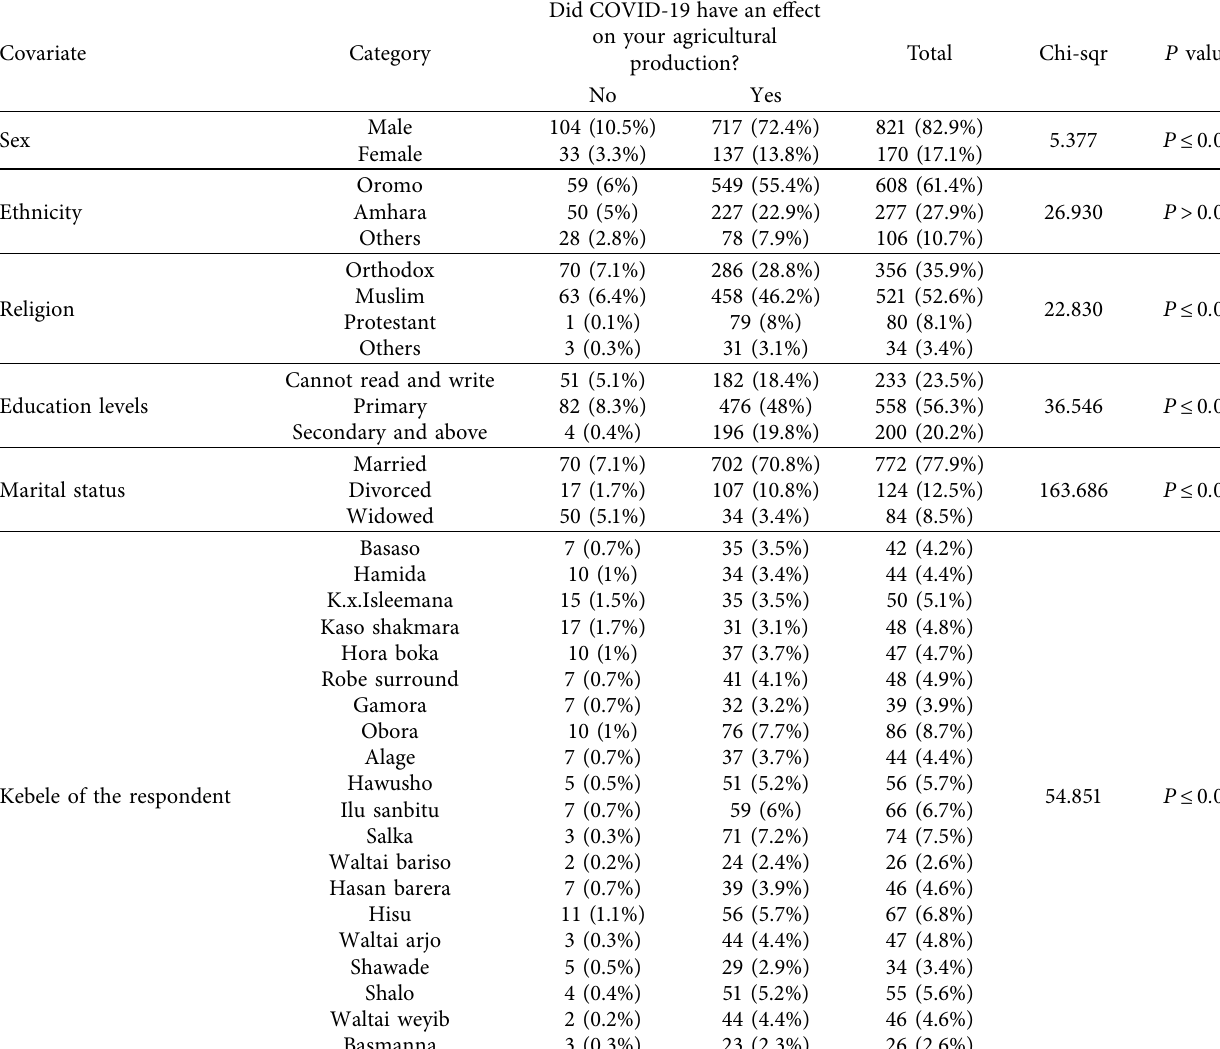
Table 1: Sociodemographic characteristics of the respondents.